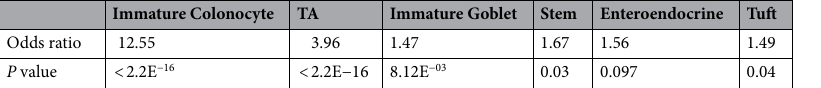
Table 3. Summary results of enrichment analysis from one-way Fisher’s exact test of overlap between significant DEGs identified in regression on cell score and known markers of cell composition.